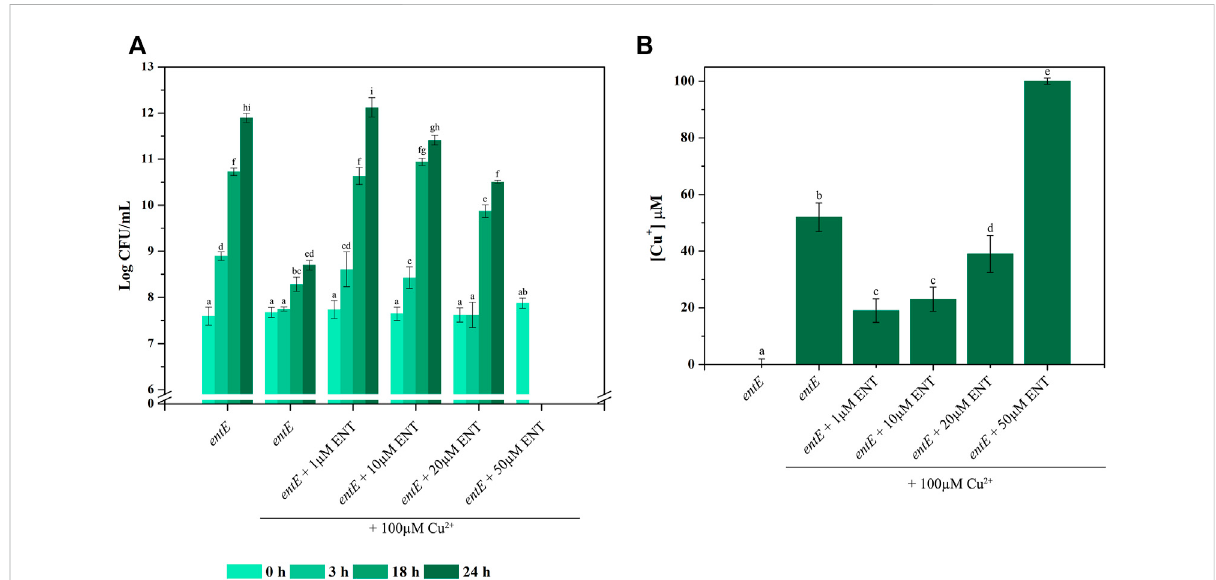
FIGURE 6 Concentrationdependenteffectofenterobactinoncoppertoxicity. (A) CFU/mlatdifferenttimes(0,3,18,and24 h)for E.colientE straingrown in liquid aerated minimal M9 medium supplemented with 0, 1, 10, 20, and 50 µM of enterobactin (ENT) in presence of 100 µM of CuSO 4 . Data is plotted as the mean values ± SD of Log CFU/ml. Experiments were done in triplicates. (B) Cu + concentration was determined by means of BCDS as described in material and methods. Data is plotted as the mean values ± SD of Cu + concentrations determined at the end of the assay (24 h). Experiments were done in triplicates. Statistically signi fi cant differences between any two conditions compared are indicated with different letters ( p < 0.05). Same letters indicate no statistically signi fi cant